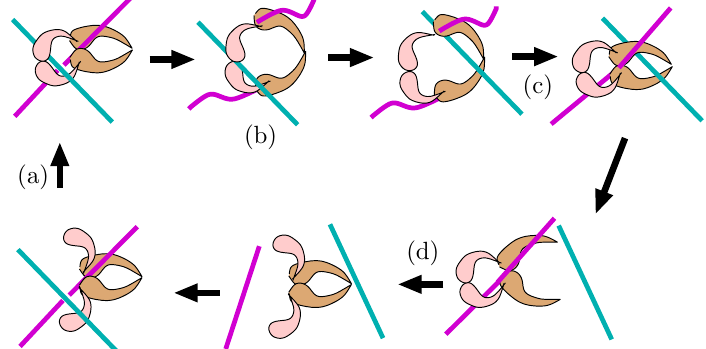
Fig. 1. (a) Topoisomerase II captures the pair of ds-DNA strands. (b) It cuts one of those strands to make a gap. (c) The other strand passes through the gap. (d) Reseals the gap and releases them.